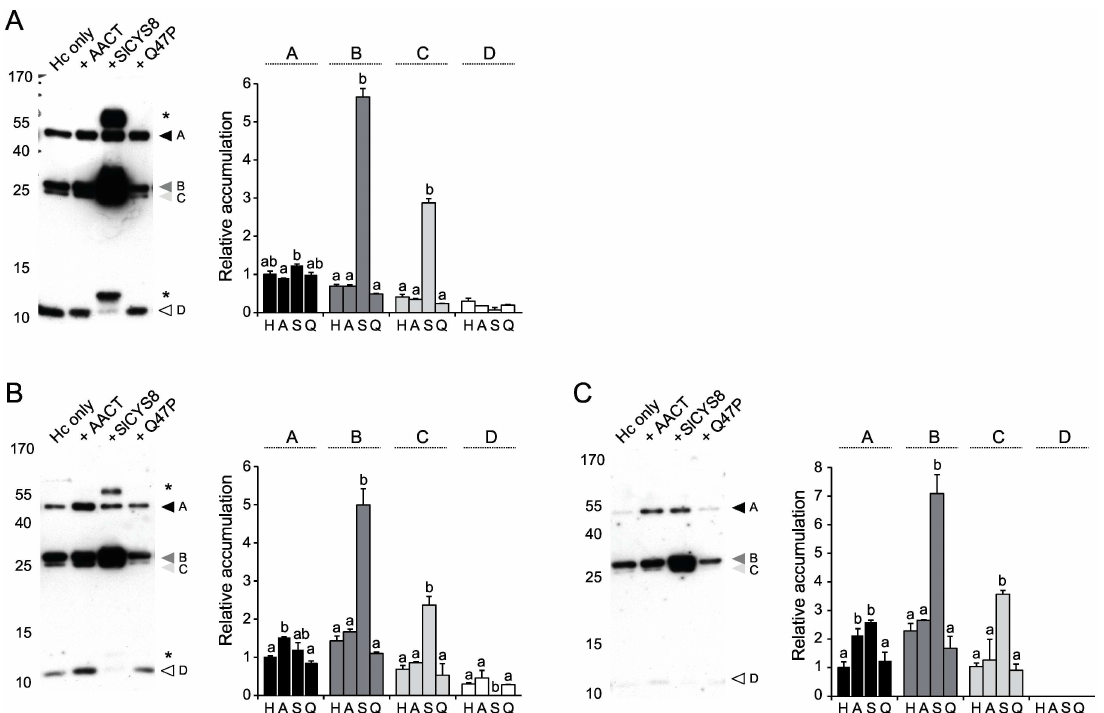
Fig 4. Impact of co-expressed protease inhibitors on the degradation profile of H10 heavy chain domains in N . benthamiana upper (A), middle (B) and bottom (C) leaves. Protein extracts with the heavy chain expressedalone or co- expressedwith protease inhibitorswere submitted to SDS-PAGE in reducingconditions and electro-transferred onto nitrocellulosemembranes for immunodetection. Heavy chain fragments in plants expressingthe heavy chain alone (H) or along with α 1 -ACT (A), SlCYS8 (S) or Q47P (Q) were detected with an anti-human γ chain HRP-conjugatedantibody.Arrows A to D point to heavy chain fragments detected in control plant extracts, and the asterisk to additionalbands detected in plants co- expressing Sl CYS8. Numbers on the left indicatethe position of molecularmass markers (kDa). Relativeaccumulation rates for fragments A to D in the histograms were determined by densitometric analysisof the immunoblot signals. Data are expressed comparedto the H alone treatment for fragment A (arbitrary value of 1). Each bar is the mean of three independent(biological) replicates ± SE . Bars with different letters are significantly different (post- ANOVA Tukey’s test; P <